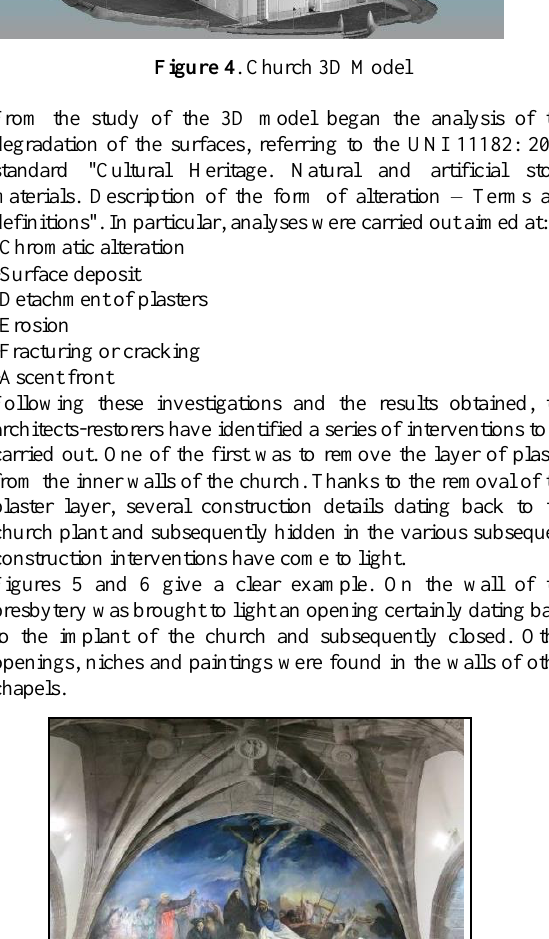
Figure 7 . Points of TLS survey – Phase